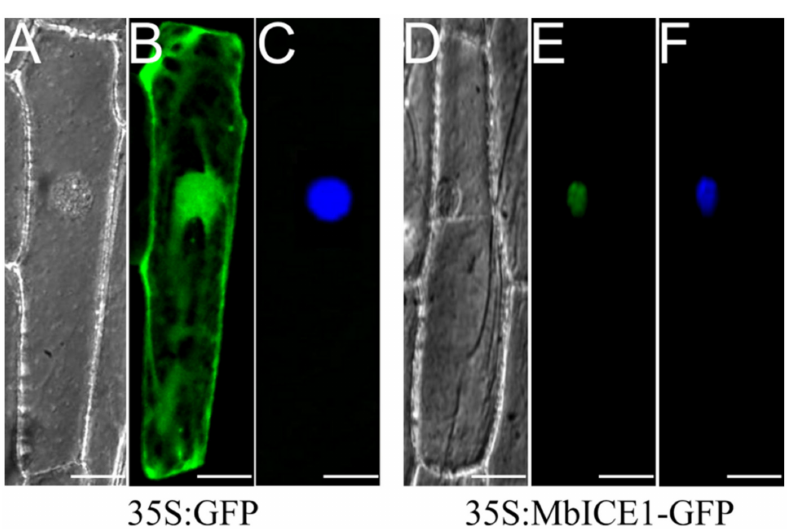
Figure 3. Subcellular localization of MbICE1. The transient vector harboring 35S:GFP and 35S:MbICE1-GFP vectors were transformed into onion epidermal cells by gene gun bombardment. ( A , D ) Bright field of vision. ( B , E ) GFP signals in dark field. ( C , F ) Effects after DAPI dyeing. The white scale bar represents 5 µ